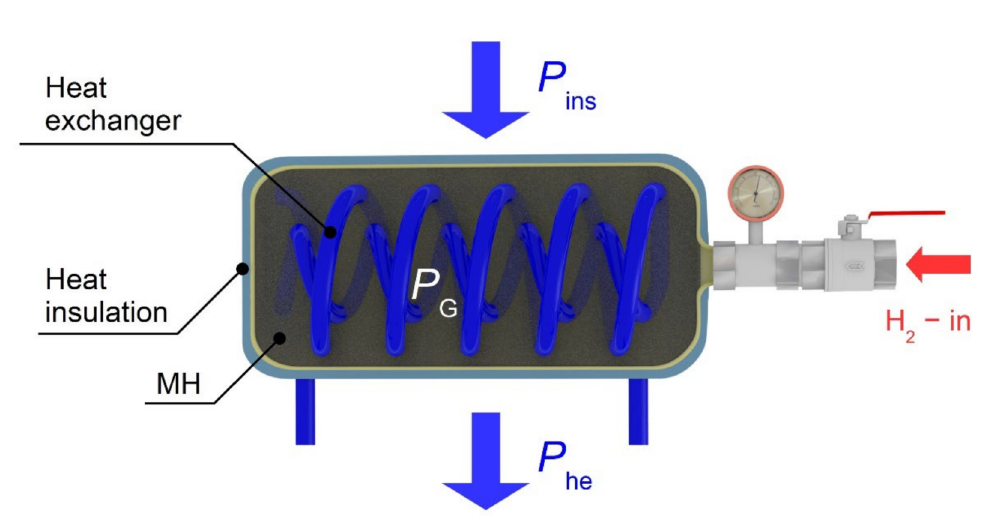
Figure 5. The MH tank and the thermal balance